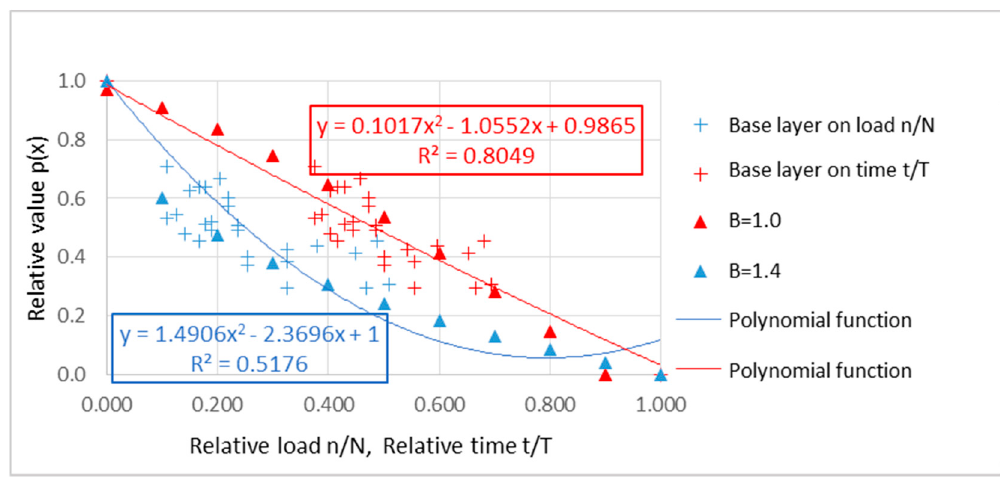
Figure 16. Degradation of the modulus of elasticity depending on the time t/T and load n/N.